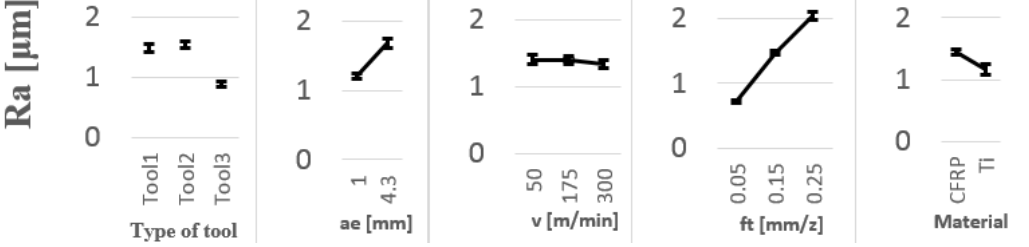
Figure 20. Ra main effect plot using ±Standard error of the mean.